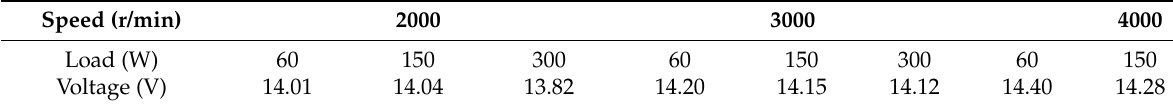
Table 2. Experiment results of output voltage.